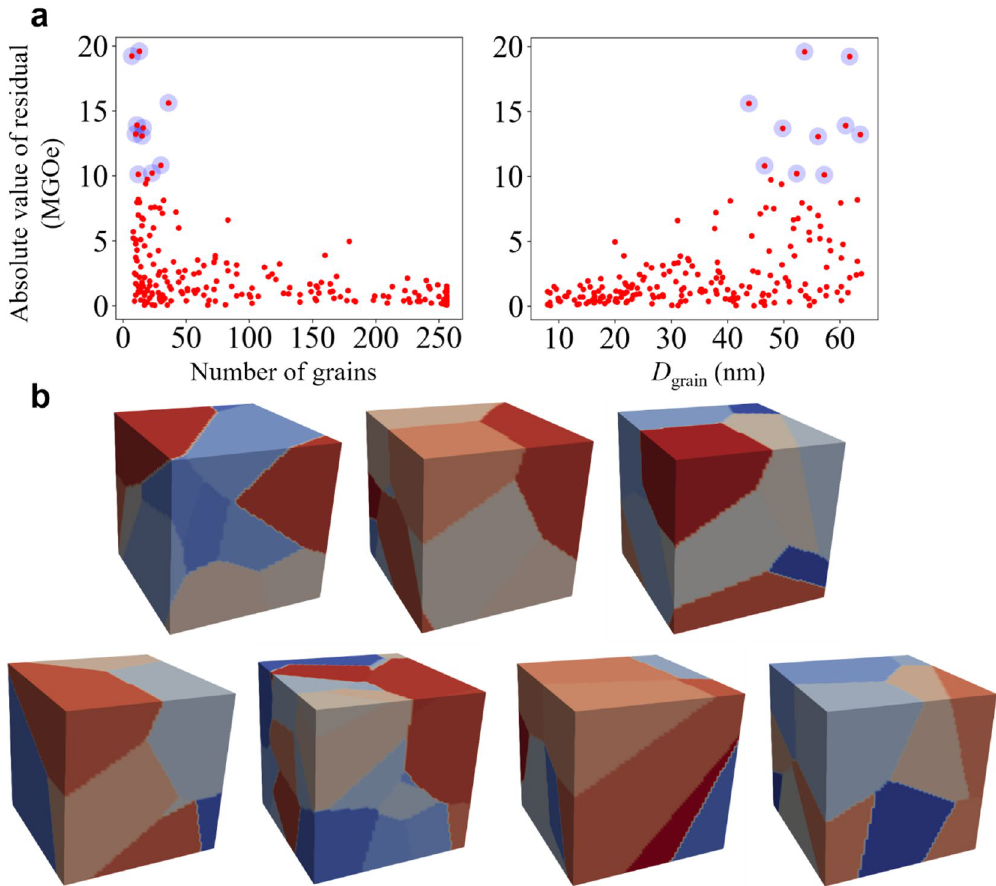
Figure 7. Origin of seven outliers. (a) Residuals between predicted and actual values of BH max against the number of grains and D grain as obtained using ANN model. The seven outliers with residuals larger than 13 MGOe are indicated by the blue translucent dots. (b) Model cuboids for seven outliers with grains indicated by different colors. The model cuboids were visualized with